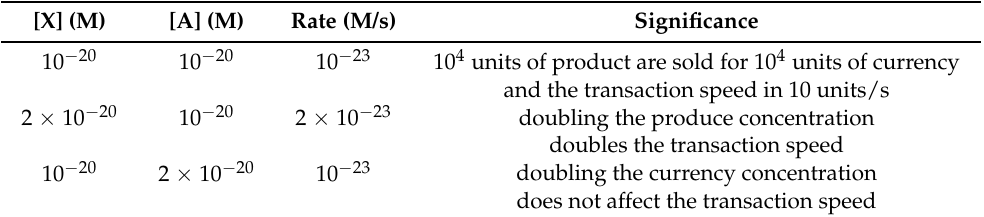
Table A2. Experimental assumptions for [ X ] in the non-elementary framework, [ A ] (cid:29) [ Z ] . [X] (M) [A] (M) Rate (M/s) Significance 10 − 20 10 − 20 10 − 23 10 4 units of product are sold for 10 4 units of currency and the transaction speed in 10 units/s 2 × 10 − 20 10 − 20 2 × 10 − 23 doubling the produce concentration doubles the transaction speed 10 − 20 2 × 10 − 20 10 − 23 doubling the currency concentration does not affect the transaction